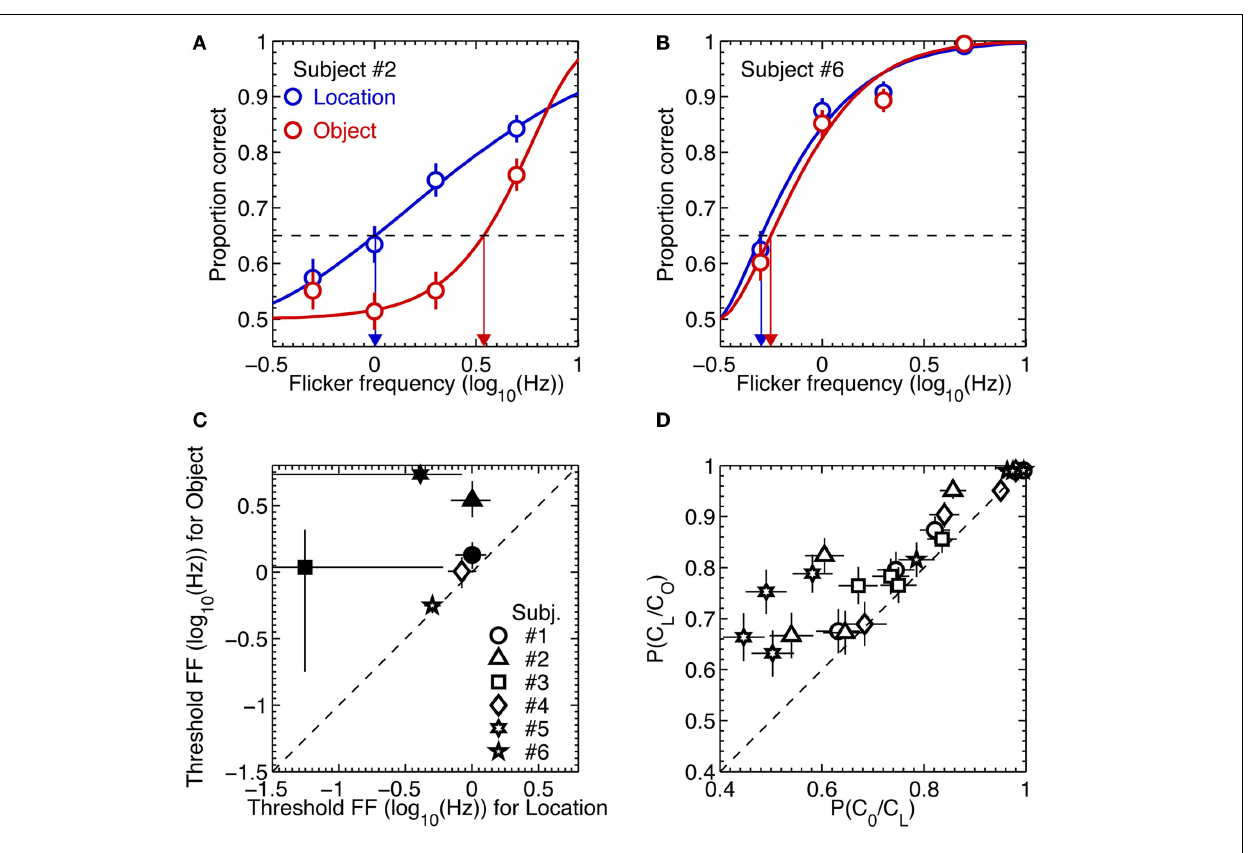
statistically significant differences in threshold between the two tasks are indicated by the solid symbols.The error bars are 95% confidence intervals, estimated from 2000 parametric bootstrap samples. (D) The conditional probability of being correct in the object task given correct location judgment are plotted against the conditional probability of being correct in the location task given correct object judgment for each of flicker frequency and for each subject.The different symbols represent different observers.The error bars are the standard errors of proportion correct, estimated from binomial